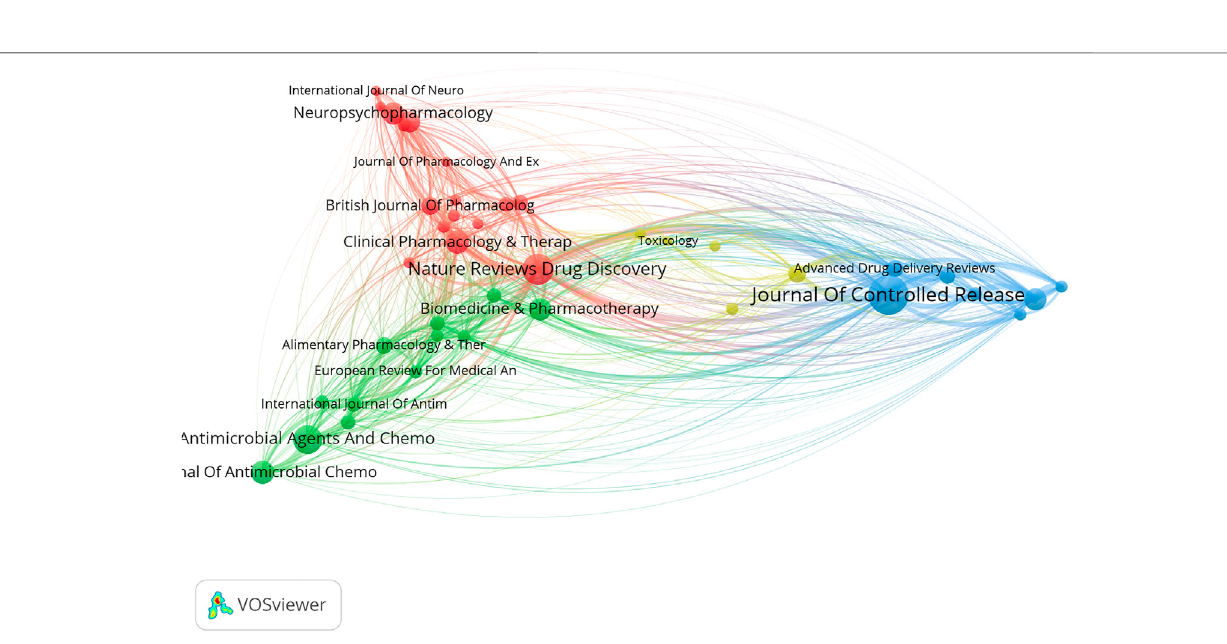
Frontiers in Pharmacology |